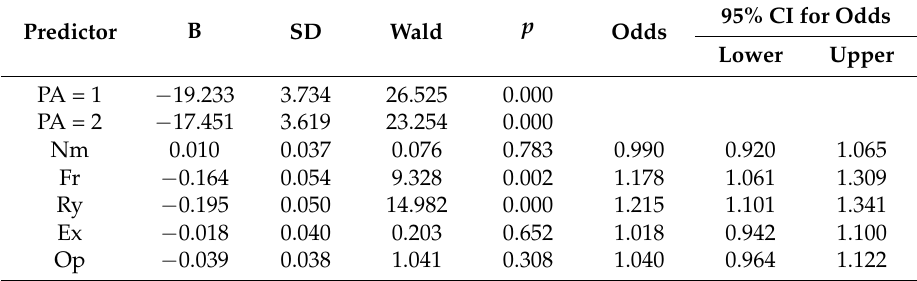
Table 5. Ordinal logistic regression for the personal accomplishment